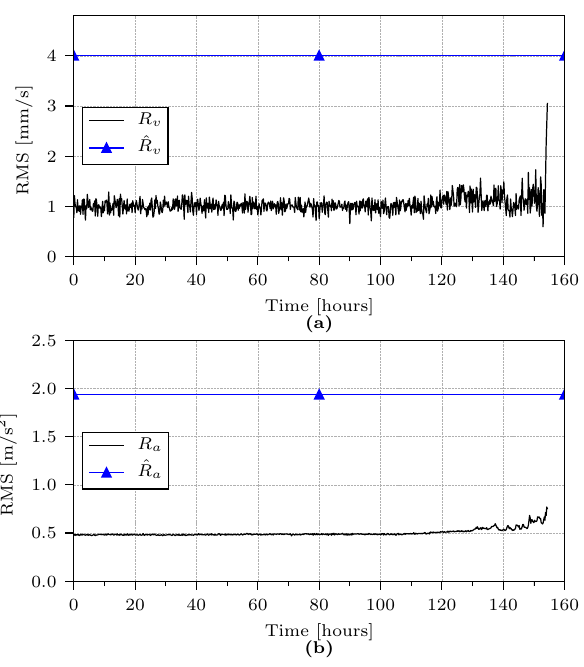
Figure 7: Comparison of velocity- and acceleration- based RMS of the in-house test rig dataset. (a) velocity-based RMS; (b) acceleration- based